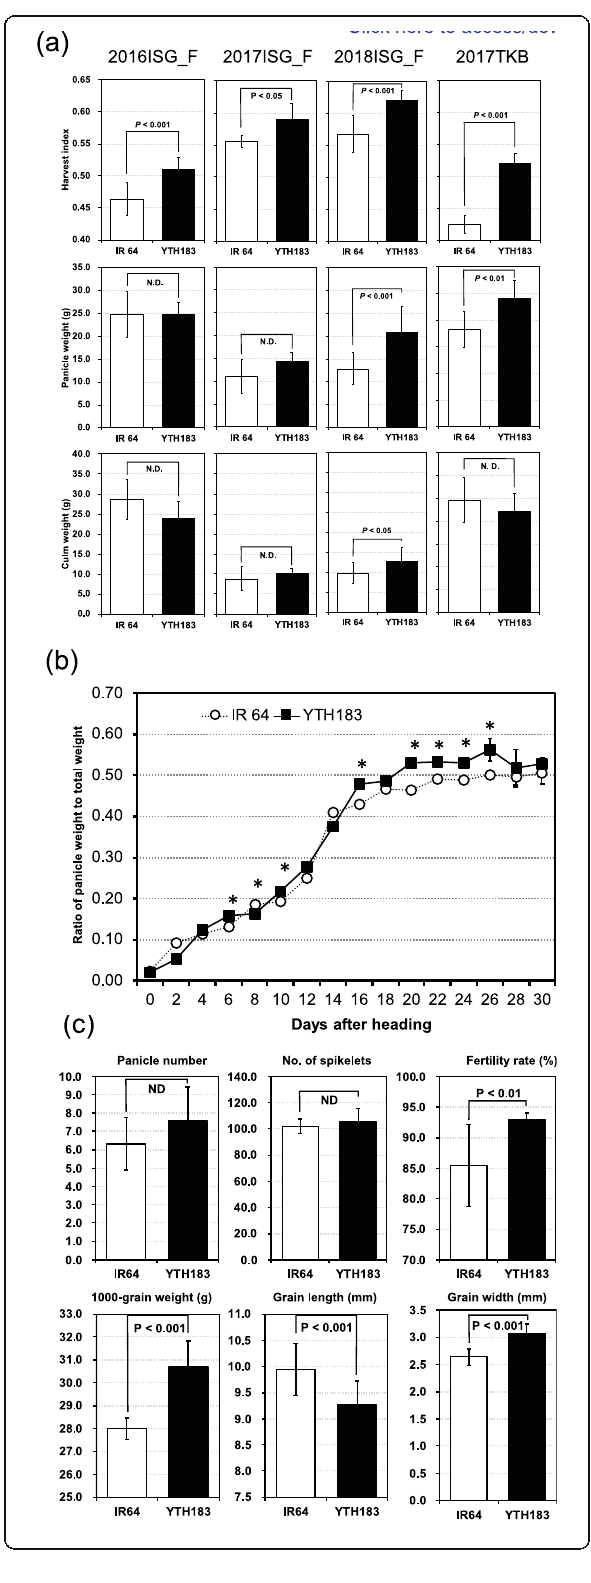
Fig. 1 Comparison of HI and yield-related traits between IR 64 and YTH183. Data are expressed as means ± SD ( n = 6 plants). a HI, panicle weight, and culm (and leaf) weight in Tsukuba (2017TKB) and three first-cropping seasons at Ishigaki in 2016, 2017, and 2018 (2016ISG_F, 2017ISG_F, and 2018ISG_F). The P value indicates statistical analysis by Student ’ s t-test. N.D. indicates no significant difference. b Transitions of HI between IR 64 and YTH183 in the first cropping at Ishigaki in 2017. The asterisks represent a significant difference between the two parents ( P < 0.05) based on Student ’ s t- test. c Comparison of six yield-related traits between IR 64 and YTH183 in the first cropping at Ishigaki in 2018. The P value indicates statistical analysis by Student ’ s t-test. N.D. indicates